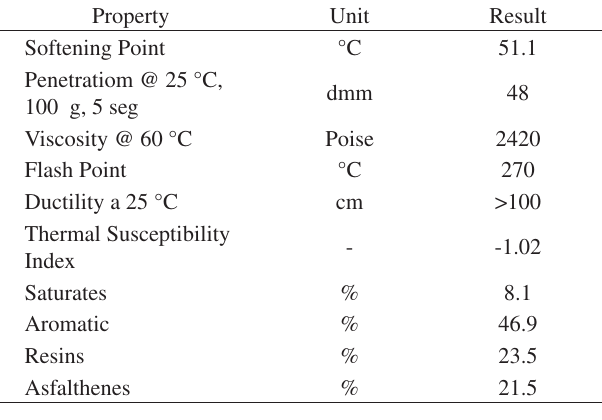
Table 4. Properties of asphalt cement